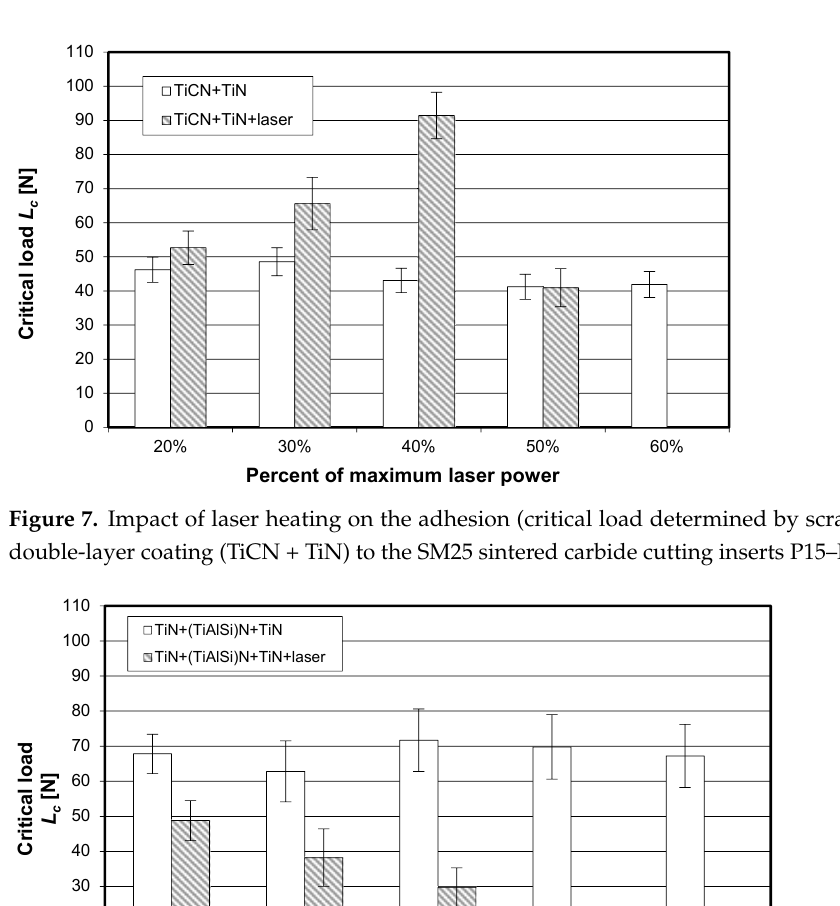
Figure 6. Impact of laser heating on the adhesion (critical load determined by scratch test) of the single-layer coating (TiN) to the SM25 sintered carbide cutting inserts (P15–P40).